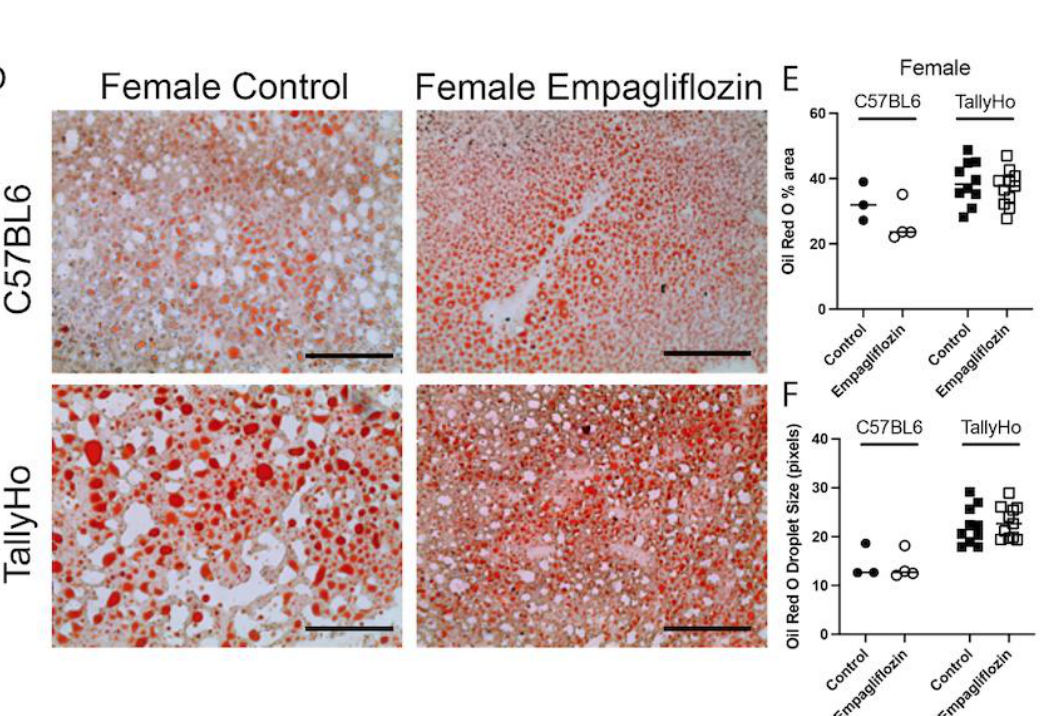
Figure 7. Hepatic neutral lipids are not changed upon Empagliflozin treatment. Livers from control and Empagliflozin-treated C57BL6J and TallyHo mice were isolated, embedded in OCT, and sectioned. Fresh frozen sections were then stained with neutral lipid stain, Oil Red O. Robust red droplet stain was noted in both the male ( A – C ) and female ( D – F ) livers. Empagliflozin did not alter the total Oil Red O area ( B , E ) and only decreased droplet size ( C , F ) in C57BL6J male mice. * p < 0.05. Scale bar = 200 μ m.